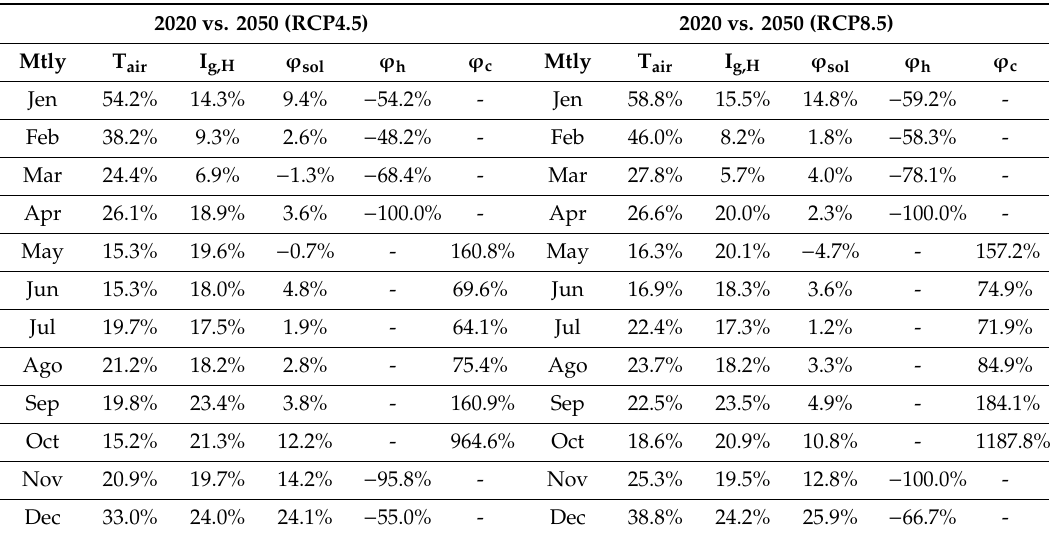
Table 5. Monthly percentage variation of the main input and output values between 2020 and the RCP4.5 and RCP8.5 (2050)